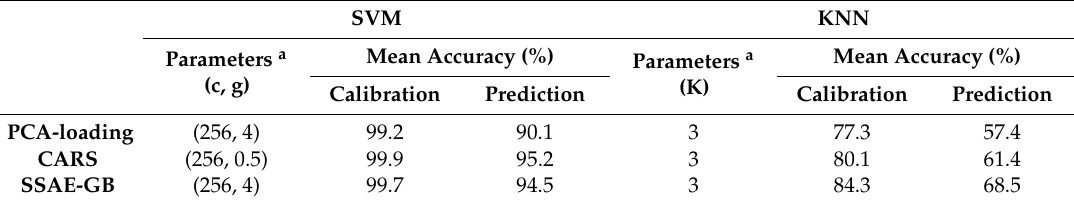
Table 2. Detection accuracy of multiple characteristic wavenumbers methods.